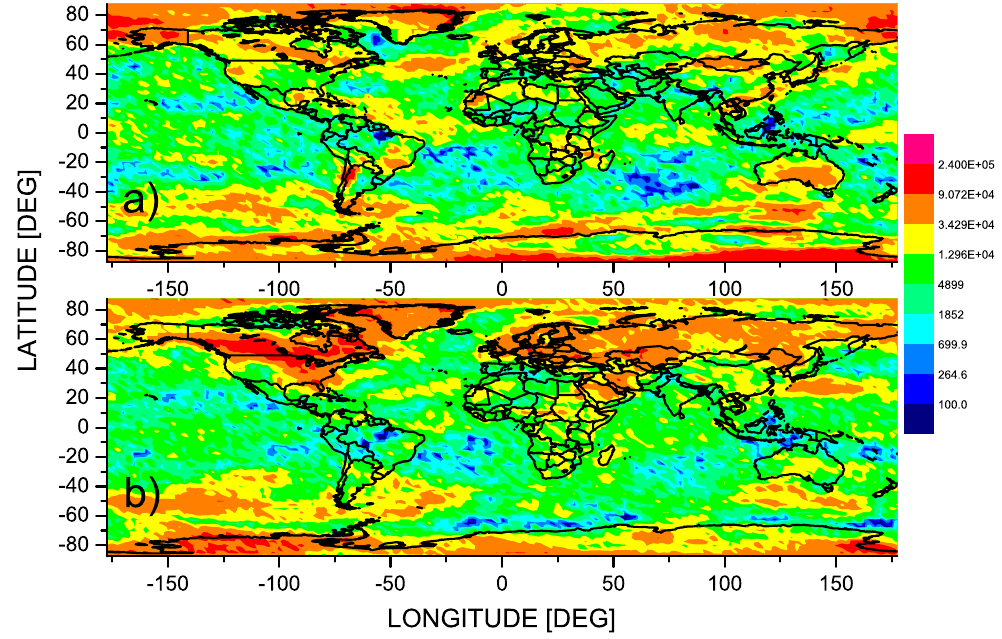
Fig. 11. Betweenness centrality for SATA climate networks with density % = 0 . 005 obtained by thresholding of the absolute correlations Z -scores related to independent univariate FT surrogate data for negative (a) and positive (b) NAO